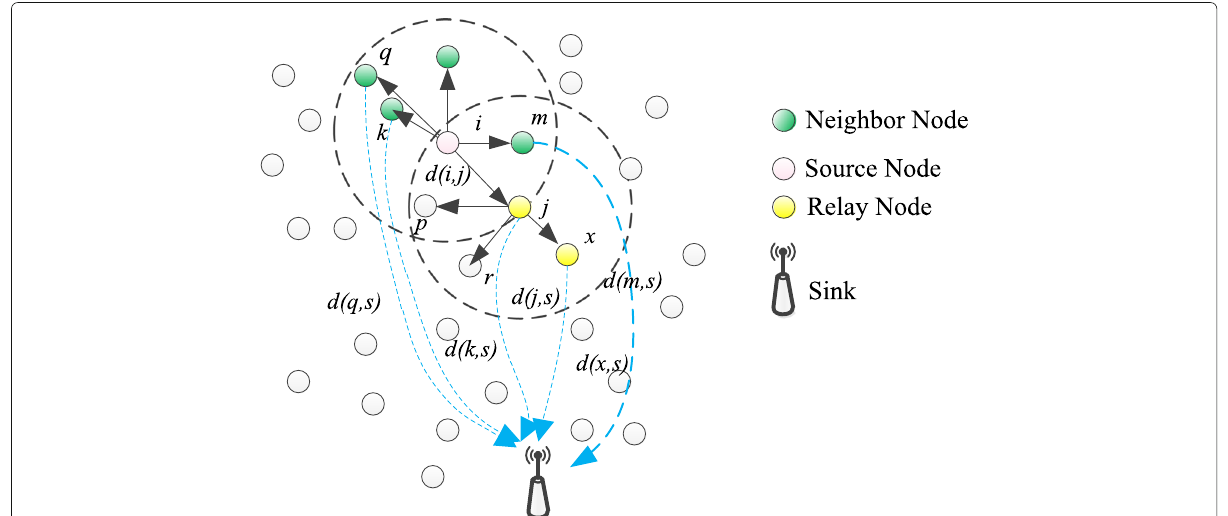
Fig. 5 Selection of relay nodes with N j . Source node calculates the distance between and the neighbor; obtains the distance between the neighbor node and sink from the neighbor node, calculating N j of all neighbors; and selects the relay